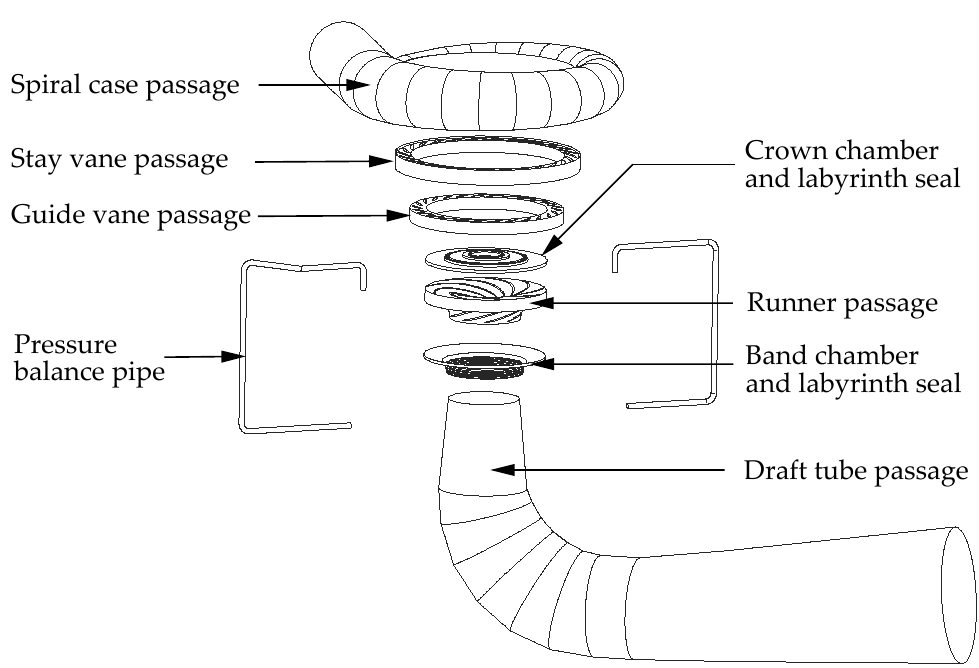
Figure 4. The 3D modeling of the flow passage of the pump-turbine unit. In this work, ANSYS CFX5 solver was used to carry out the 3D CFD simulations. The analysis type and solver type were set to stable and high-resolution, respectively. The turbulence model was set to k − ω SST and the turbulence mathematical accuracy was set to first-order with a convergence residual of 10 − 5 . The pressure values at the spiral case inlet and at the draft tube outlet were directly taken from the measurements shown in Figure 3. The runner passage was defined as a rotational domain, and the rotating speed over time during load rejection was specified based on the measured values. The other fluid passages were defined as stationary domains. The interfaces between guide vanes and runner and runner and draft tube were set to Frozen Rotor, and the others are set to general connection. A non-slip wall was used as the wall boundary